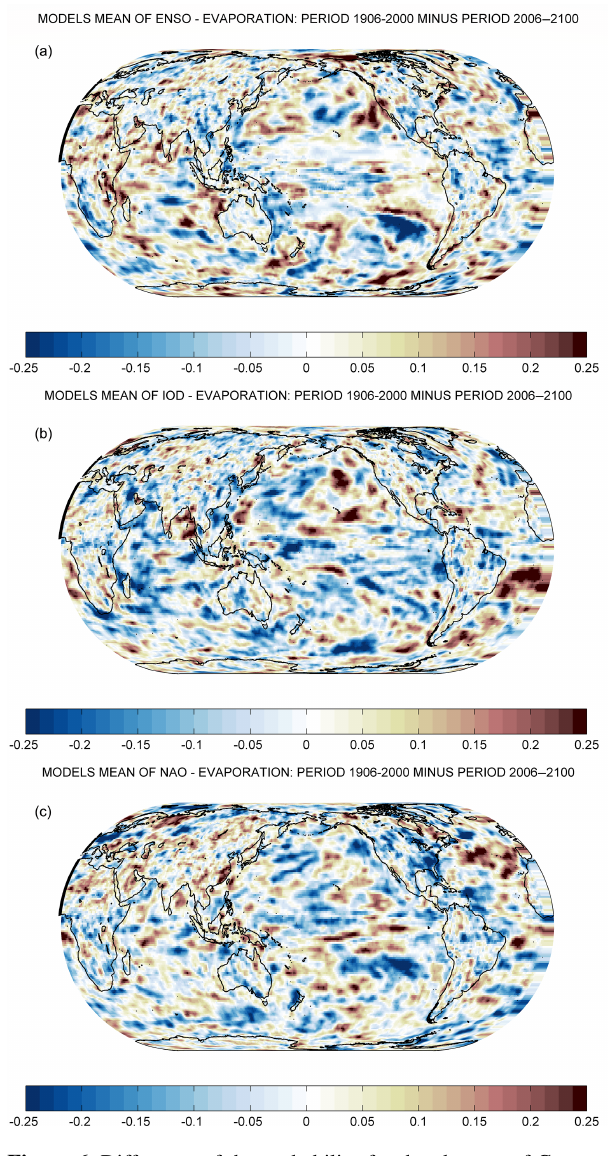
Figure 6. Difference of the probability for the absence of Granger causality of the individual climate mode on annual mean evapo- ration between the periods 1906–2000 and 2006–2100 (i.e., pe- riod 1906–2000 minus period 2006–2100). The results are shown for ENSO (a) , the IOD (b) and NAO (c) . Blue shades indicate a lower probability of no Granger causality during the period 1906– 2000 compared to the period 2006–2100. Brown shades indicate a lower probability of no Granger causality during the period 2006– 2100 compared to the period 1906–2000. ENSO: El Niño–Southern Oscillation. NAO: North Atlantic Oscillation. IOD: Indian Ocean